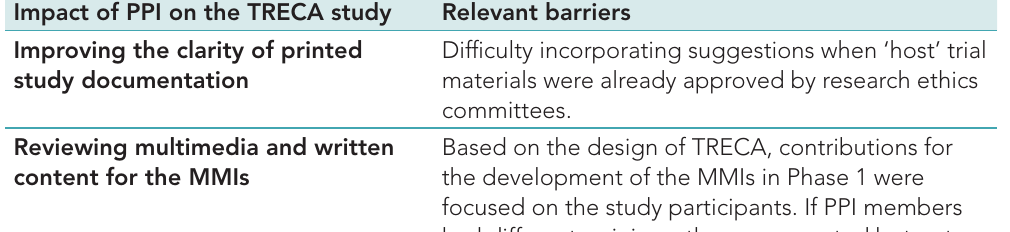
Table 2: Impact of PPI on the TRECA study and relevant barriers encountered Impact of PPI on the TRECA study